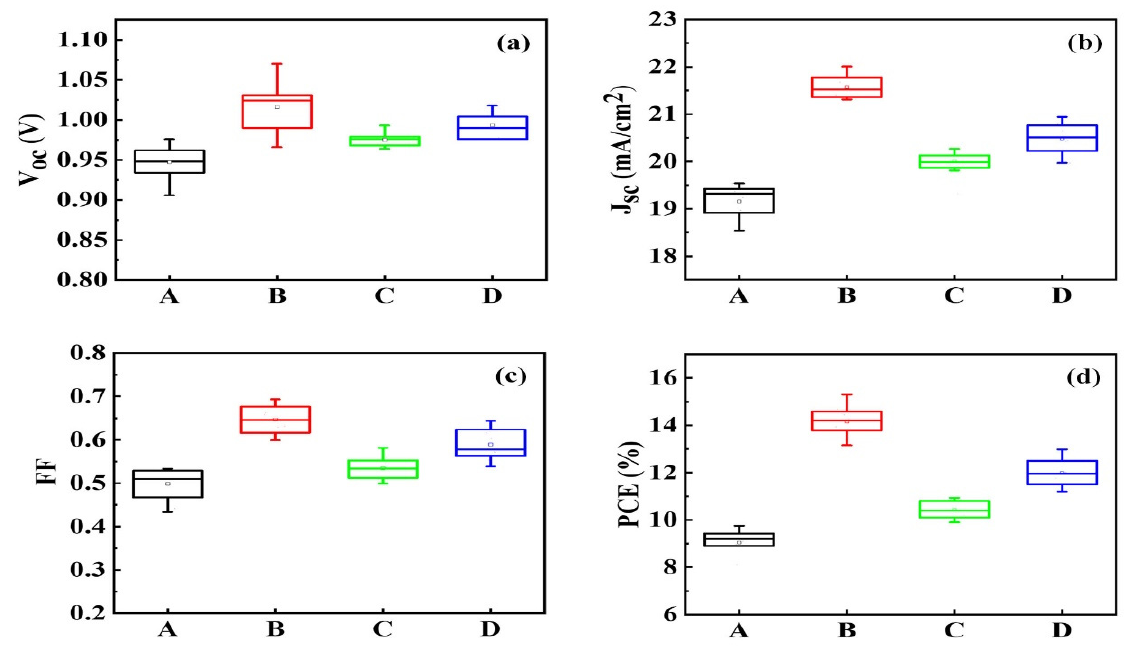
8 of 12 Figure 6. ( a ) UV–vis absorption spectra of TiO 2 NRs and TiCl 4 -treated NRs with annealing temper- ature of 150 °C, 300 °C and 450 °C, respectively; ( b ) corresponding band gap (Eg) calculated by Tauc plot. Figure 7a–d show the statistical values for the photovoltaic parameters of 15 inde- pendent PSCs, which are based on the four different ETLs, and Table 1 provides their relevant average photovoltaic parameters. According to the outcomes, the average FF, J sc and V oc of TiCl 4 -treated NR samples with different annealing temperatures are higher than those of bare TiO 2 NRs, which is mainly owing to the NRs after TiCl 4 treatment possessing a rough surface, which is beneficial for perovskite materials to infiltrate into the inter-